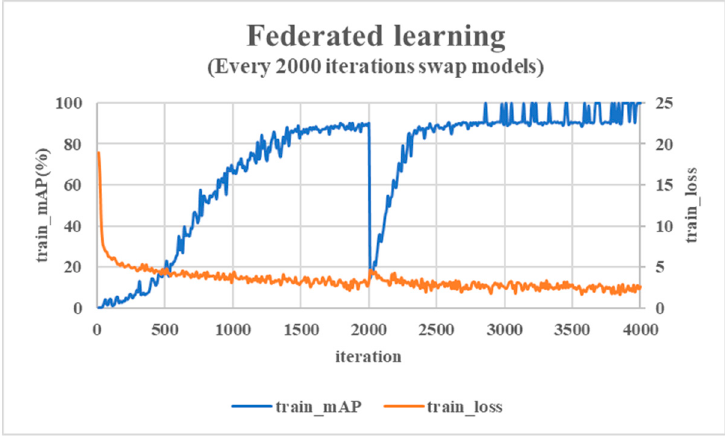
Figure 15. mAP and loss variation of the Los Angeles and Washington training data sets when exchanging models every 2000 iterations.